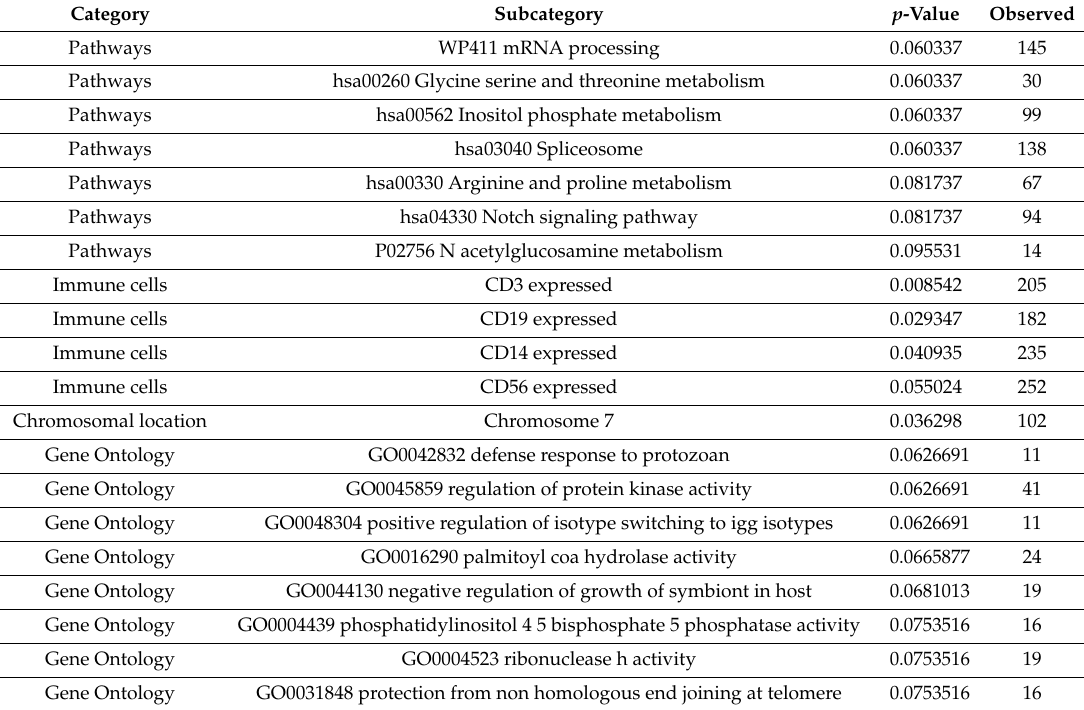
Table 4. Results of the common miRNA enrichment and